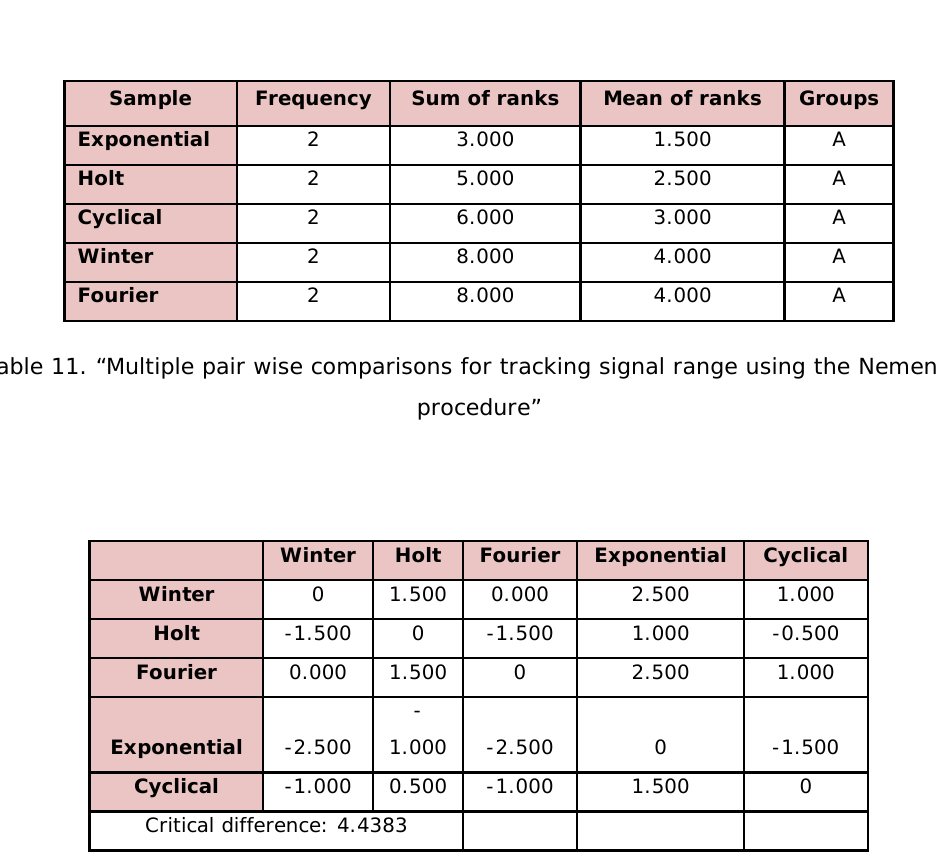
Table 12. “Pair wise differences for tacking signal”